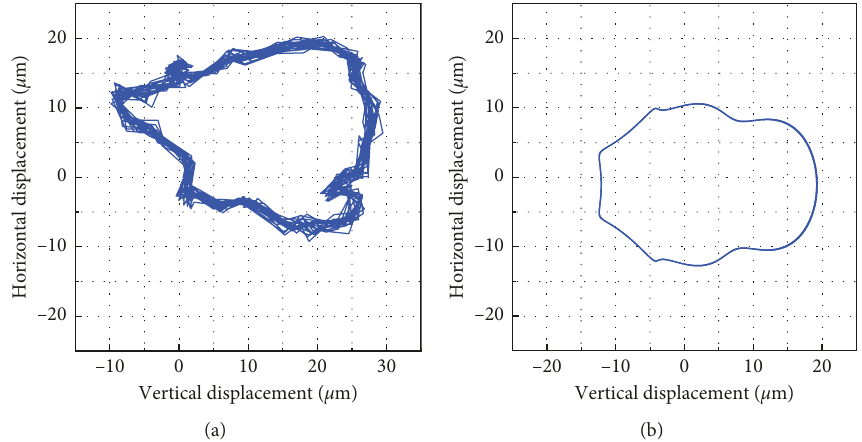
Figure 8: Comparison of the orbits under light rub-impact condition. (a) Experimental result. (b) Numerical